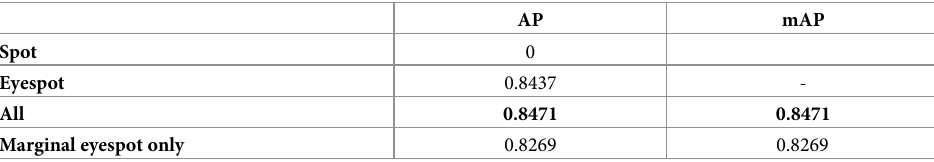
Table 3. Scores achieved by the three RetinaNet models for eyespot detection on